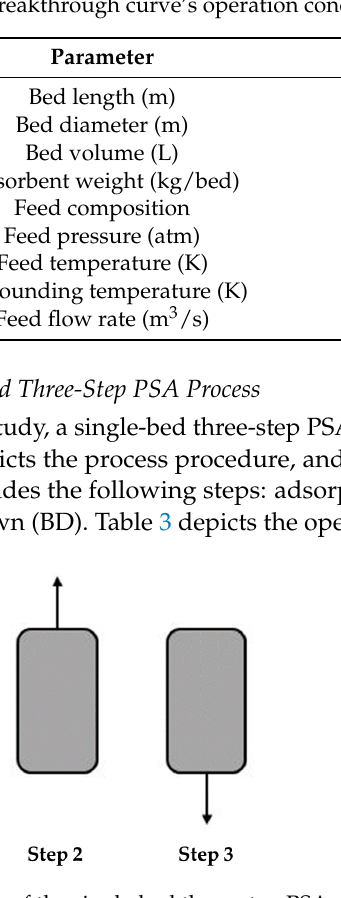
Table 1. The breakthrough curve’s operation conditions.